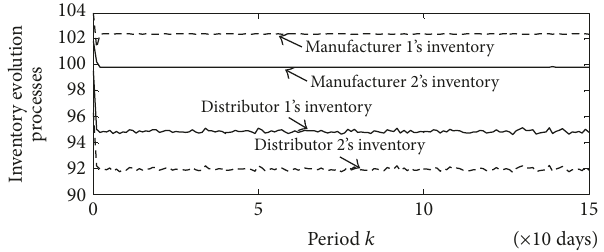
Figure 6: Ordering evolution processes from manufacturer 1 under the common robust strategy ( ×10 4 ton).